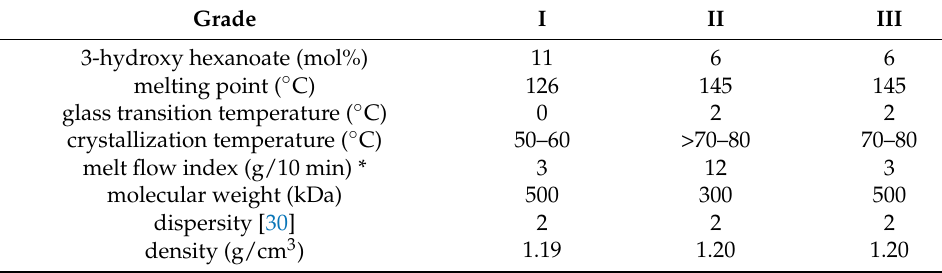
Table 1. Nominal properties of PHBH polymer grades [3]. Grade I II III 3-hydroxy hexanoate (mol%) 11 6 6 melting point ( ◦ C) 126 145 145 glass transition temperature ( ◦ C) 0 2 2 crystallization temperature ( ◦ C) melt flow index (g/10 min) * molecular weight